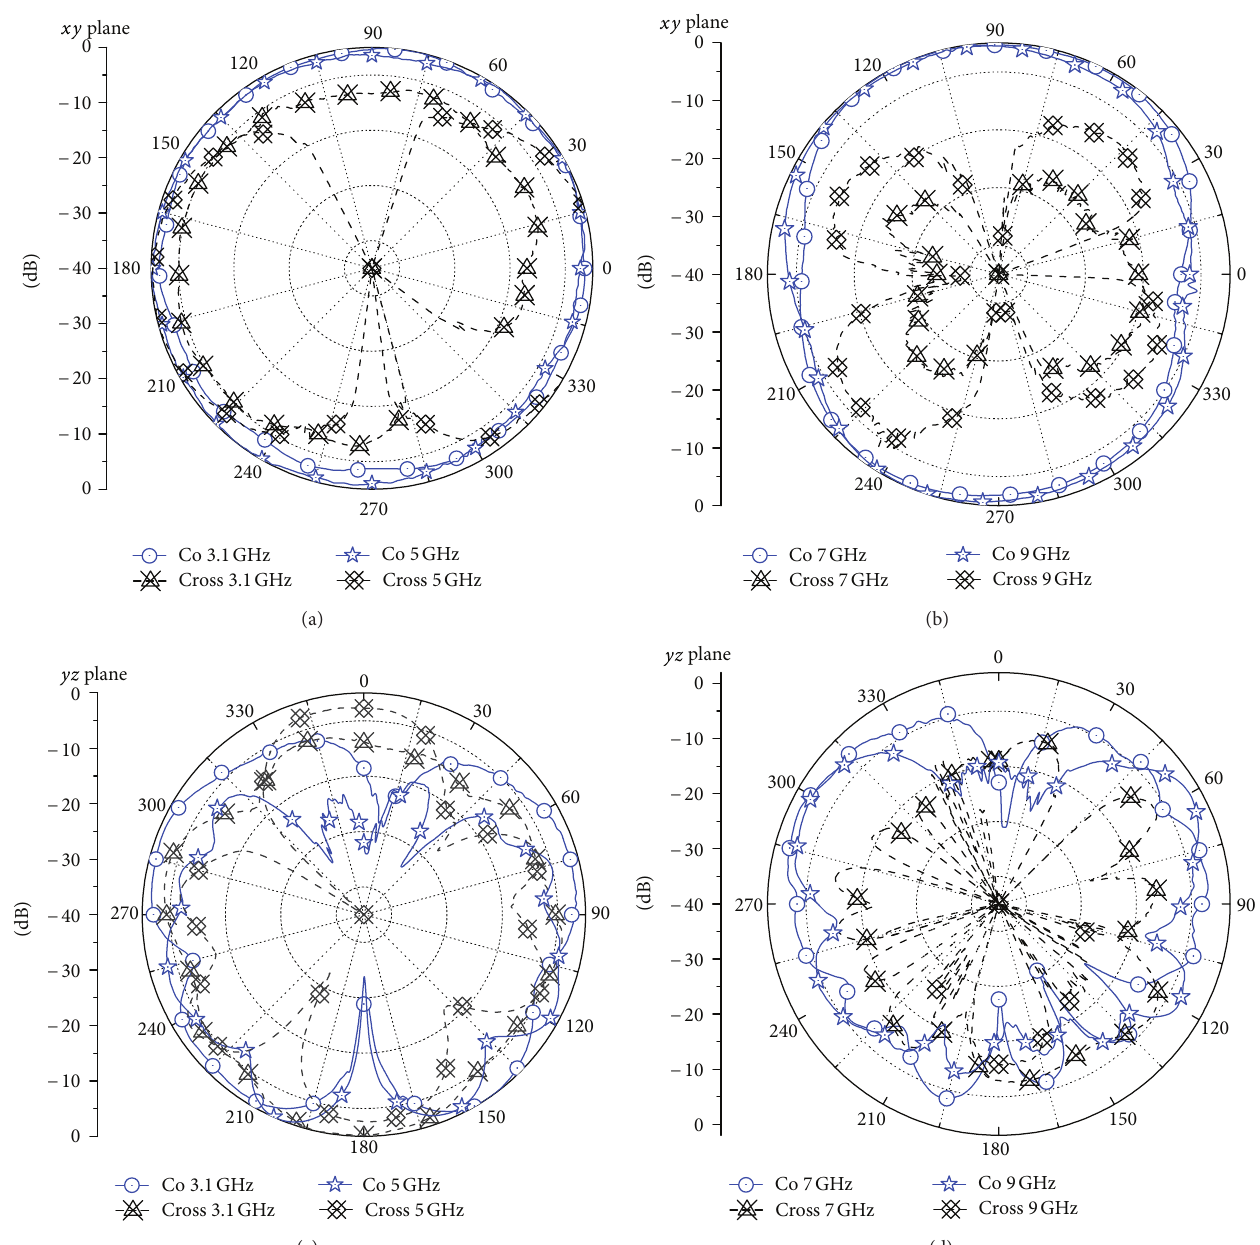
F 6: Measured radiation patterns at the frequencies of (a) 3.1, 5GHz, (b) 7, 9GHz in